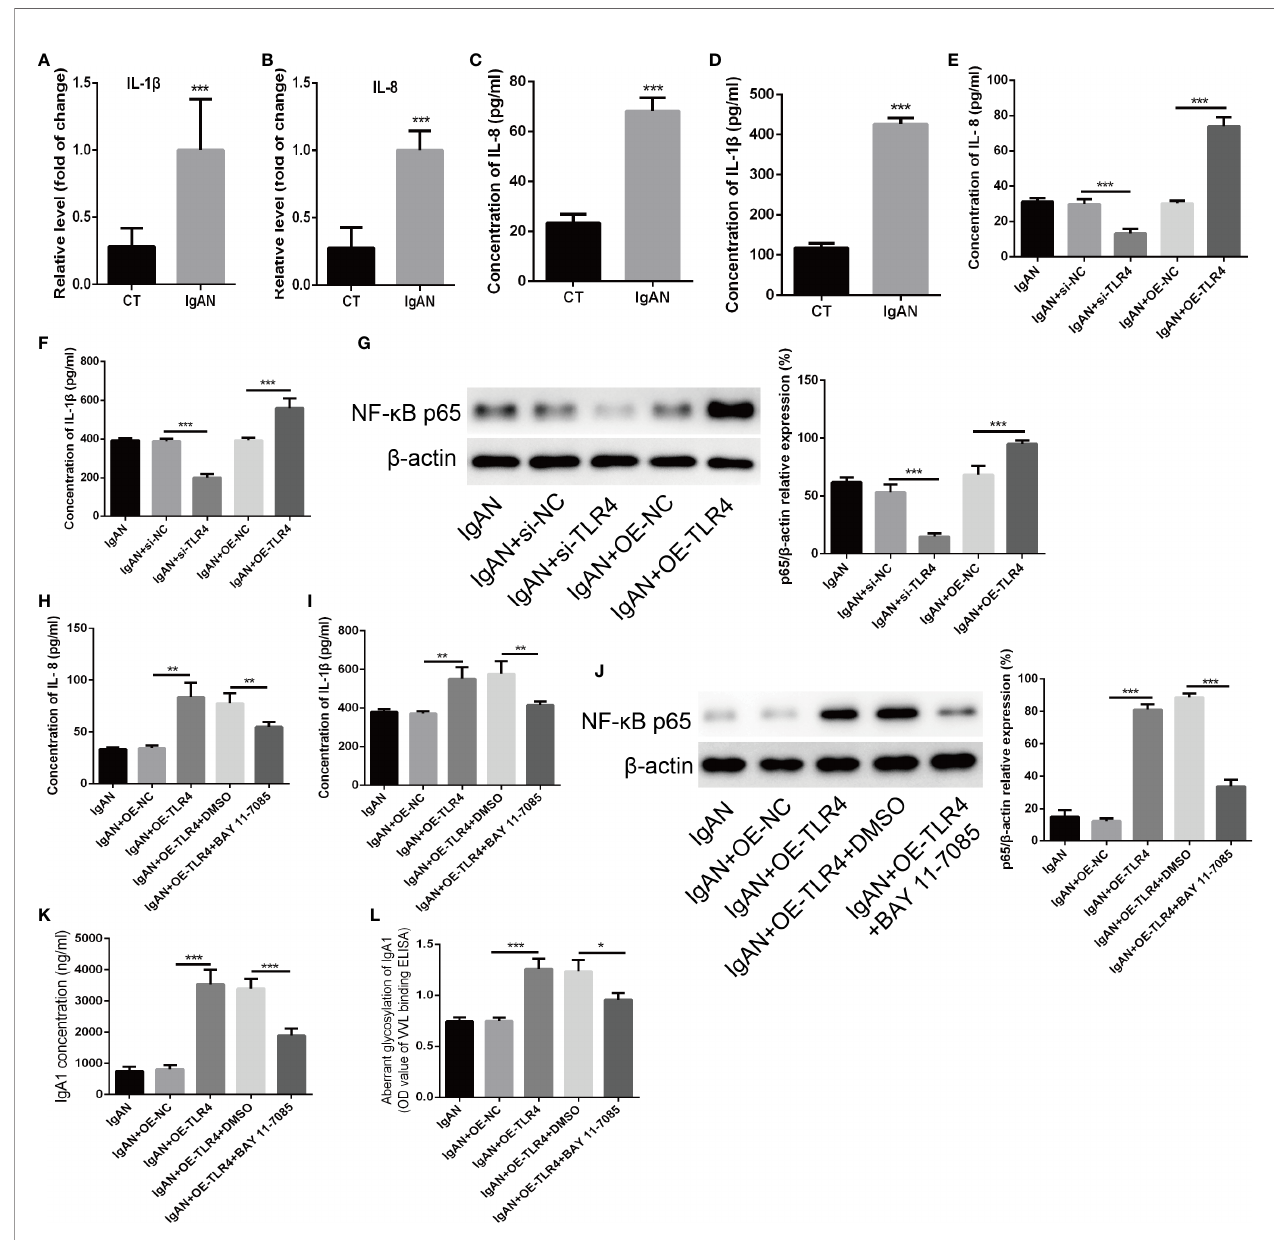
FIGURE 5 | TLR4 might regulate the concentration of IgA1 and the glycosylation level of IgA1 through NF- k B signaling pathway. (A, B) The expressions of IL-1 b and IL-8 were detected by RT-PCR in TMC from the IgAN group and CT group. (C, D) The concentrations of IL-1 b and IL-8 were measured by ELISA in TMC from the IgAN group and CT group. (E, F) The concentrations of IL-11 b and IL-8 were measured by ELISA when knocking down the expression of TLR4 by using TLR4 siRNA or overexpression of TLR4 in TMC. (G) The level of NF- k B p65 was measured by western blot analysis when knocking down the expression of TLR4 by using TLR4 siRNA or overexpression of TLR4 in TMC. (H, I) The effect of TLR4 on the concentration of IL-1 b and IL-8 were measured by ELISA when blocking the NF- k B p65 signaling pathway by using BAY 11-7085. (J) The effect of BAY 11-7085 on inhibiting NF- k B p65 signaling pathway was tested by western blot analysis. (K, L) The effect of TLR4 on the concentration of IgA1 and the glycosylation level of IgA1 were abolished by blocking the NF- k B p65 signaling pathway. The data were expressed as mean ± SD. *p < 0.05. **p < 0.01.***p < 0.001. IgAN, IgA nephropathy; CT, chronic tonsillitis; NC, negative